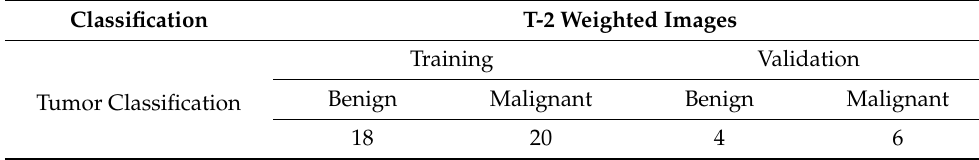
Table 2. T-2 weighted images for the experiment.